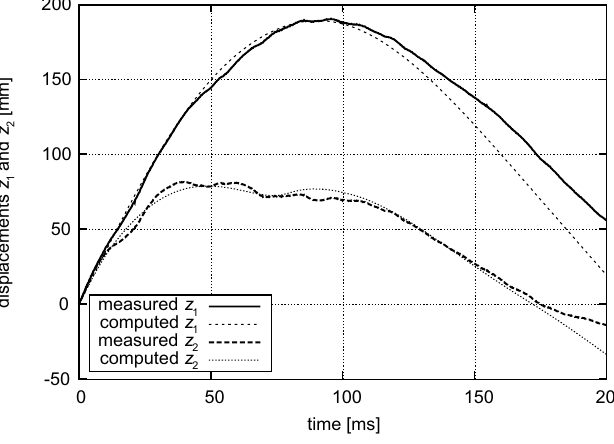
Fig. 5. Measured and computed displacements of aircraft z 1 and tire z 2 , passive LG, test case 2 ( m = 422 kg , v 0 = 3 . 52 m / s , L = 1 ). – Active LG (ALG). The orifice area A o changes continuously during the landing process, according to a